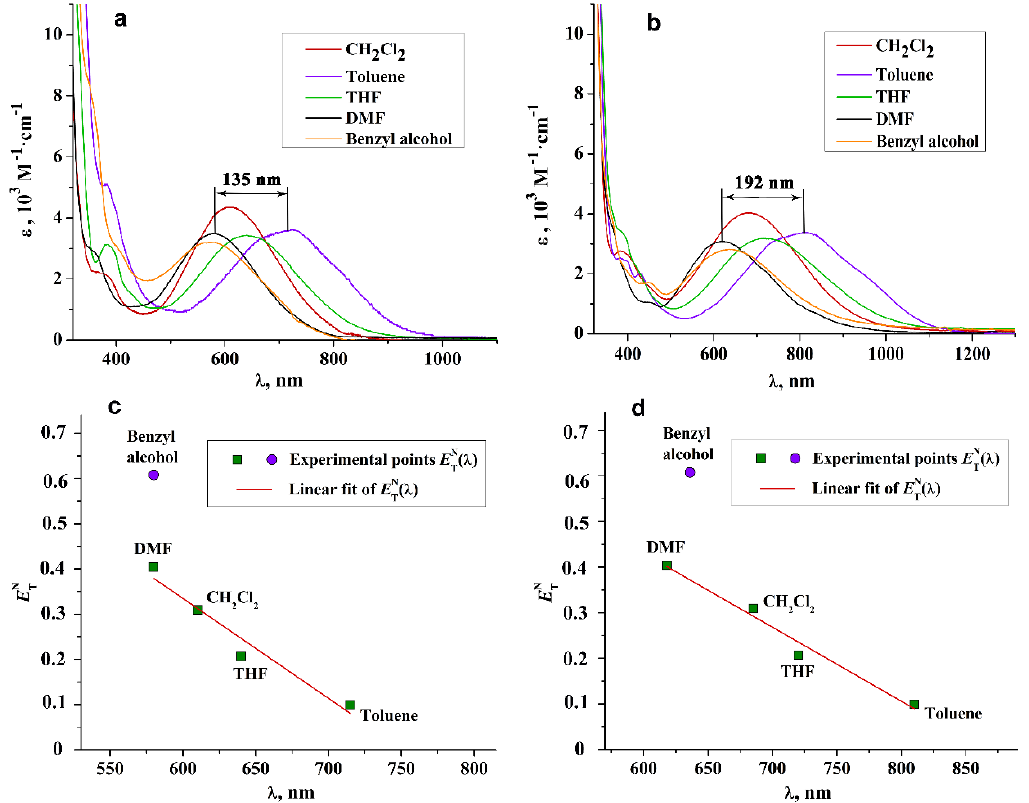
Figure 6. UV-vis-NIR spectra for 1 ( a ) and 2 ( b ); E TN (λ) dependences accompanied with linear fits for 1 ( c ) and 2 ( d ). Figure 6. UV-Vis-NIR spectra for 1 ( a ) and 2 ( b ); E TN ( λ ) dependences accompanied with linear fits for 1 ( c ) and 2 ( d ).